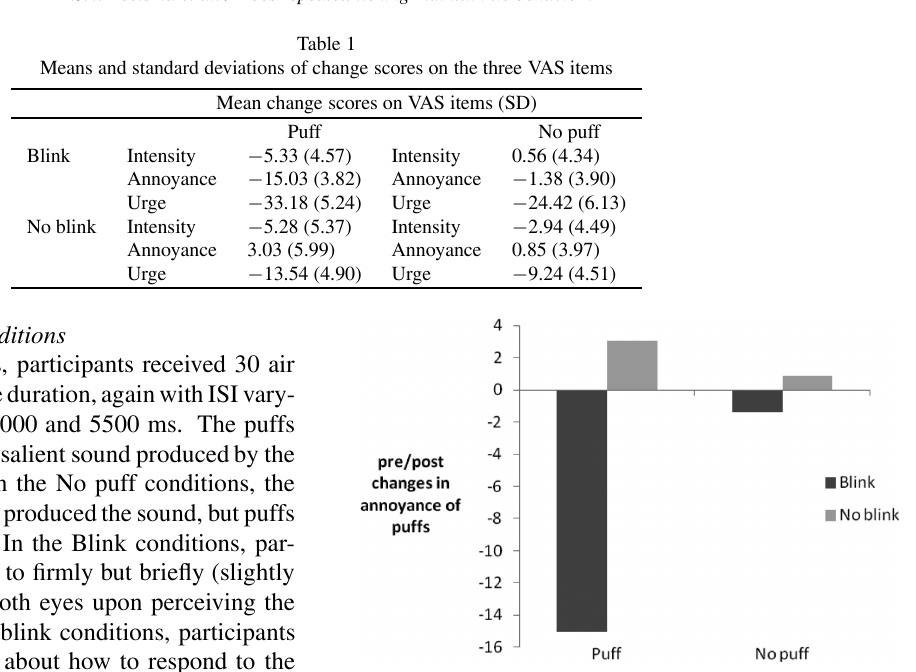
Fig. 2. Pretest to posttest changes in annoyance of puffs after tics/air puffs. 3.94, p < 0.001, while in the other three conditions it did not, all t s < 0.51, all p s > 0.62. Thus, only in the experimental Puff + Blink condition annoyance was reduced. See Fig. 2 and Table 1 for means and standard deviations of change